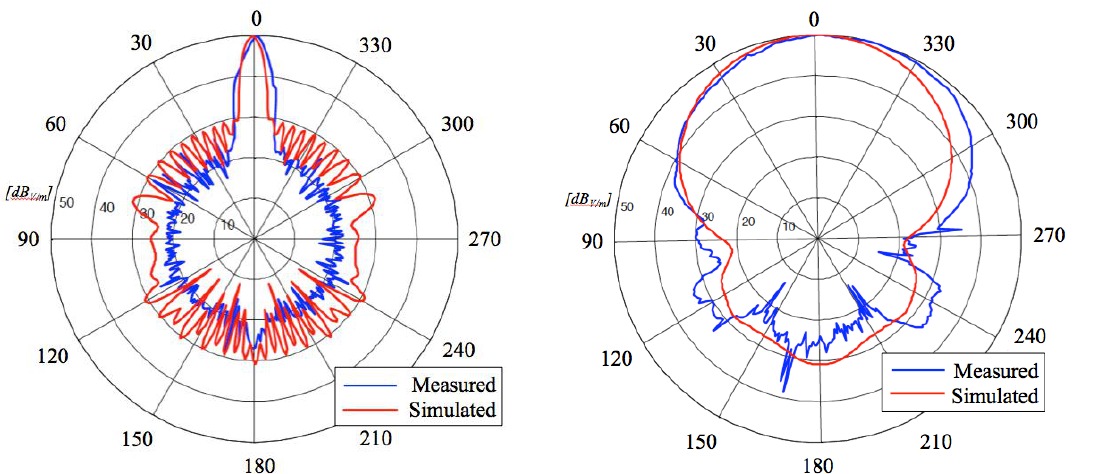
Figure 7. Reflection coefficient of the transmitting antenna: a comparison between calculated and measured values.